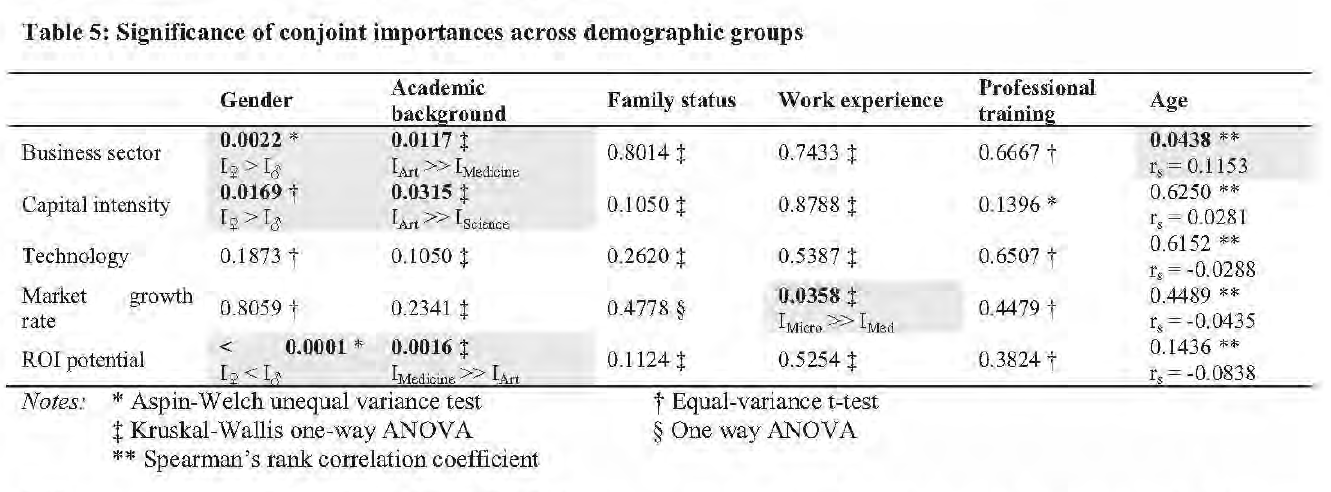
Table 5: Significance of conjoint importances across demographic